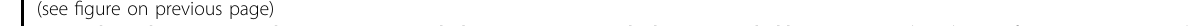
Fig. 1 The redox status was heterogeneous in cholangiocarcinoma, which was revealed by HyPer3. A The scheme of HyPer3 structure and its oxidation and reduction reaction. B, C QBC939 and HUCCT1 cells were transfected with HyPer3 plasmid for 48 h and the ratio of fl uorescence (F488/ F405nm) was observed under fl ow-cytometric analysis and confocal microscopy with the treatment of PBS, hydrogen peroxide (100 μ M), and DTT (5 mM), respectively. D Quanti fi cation of C . n = 10 cells/group. E Percentage of ROS differed subpopulations and their accurate ratio of QBC939 and HUCCT1 was measured by fl ow-cytometric analysis. F, G Quanti fi cation of E . Each experiment was performed in triplicate. H Percentage of ROS differed subpopulations and their accurate ratio of QBC939 and HUCCT1 was measured by confocal microscopy. I , J Quanti fi cation of H . Each experiment was performed in triplicate. * p < 0.05; ** p < 0.01; *** p <